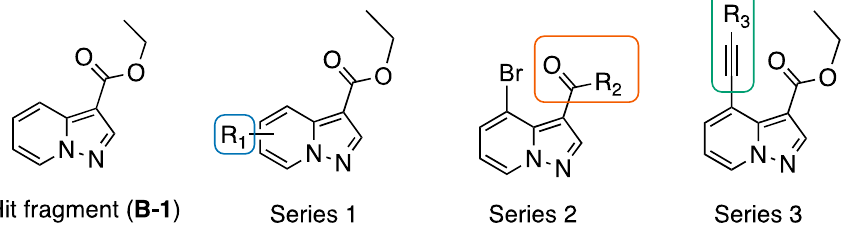
Figure 2. The compound B-1 and the structural features of the three series synthesized in this study; Series 1 with changes around the core depicted in blue, Series 2 with changes to the ester depicted in orange and Series 3 with various alkyne extensions depicted in green.